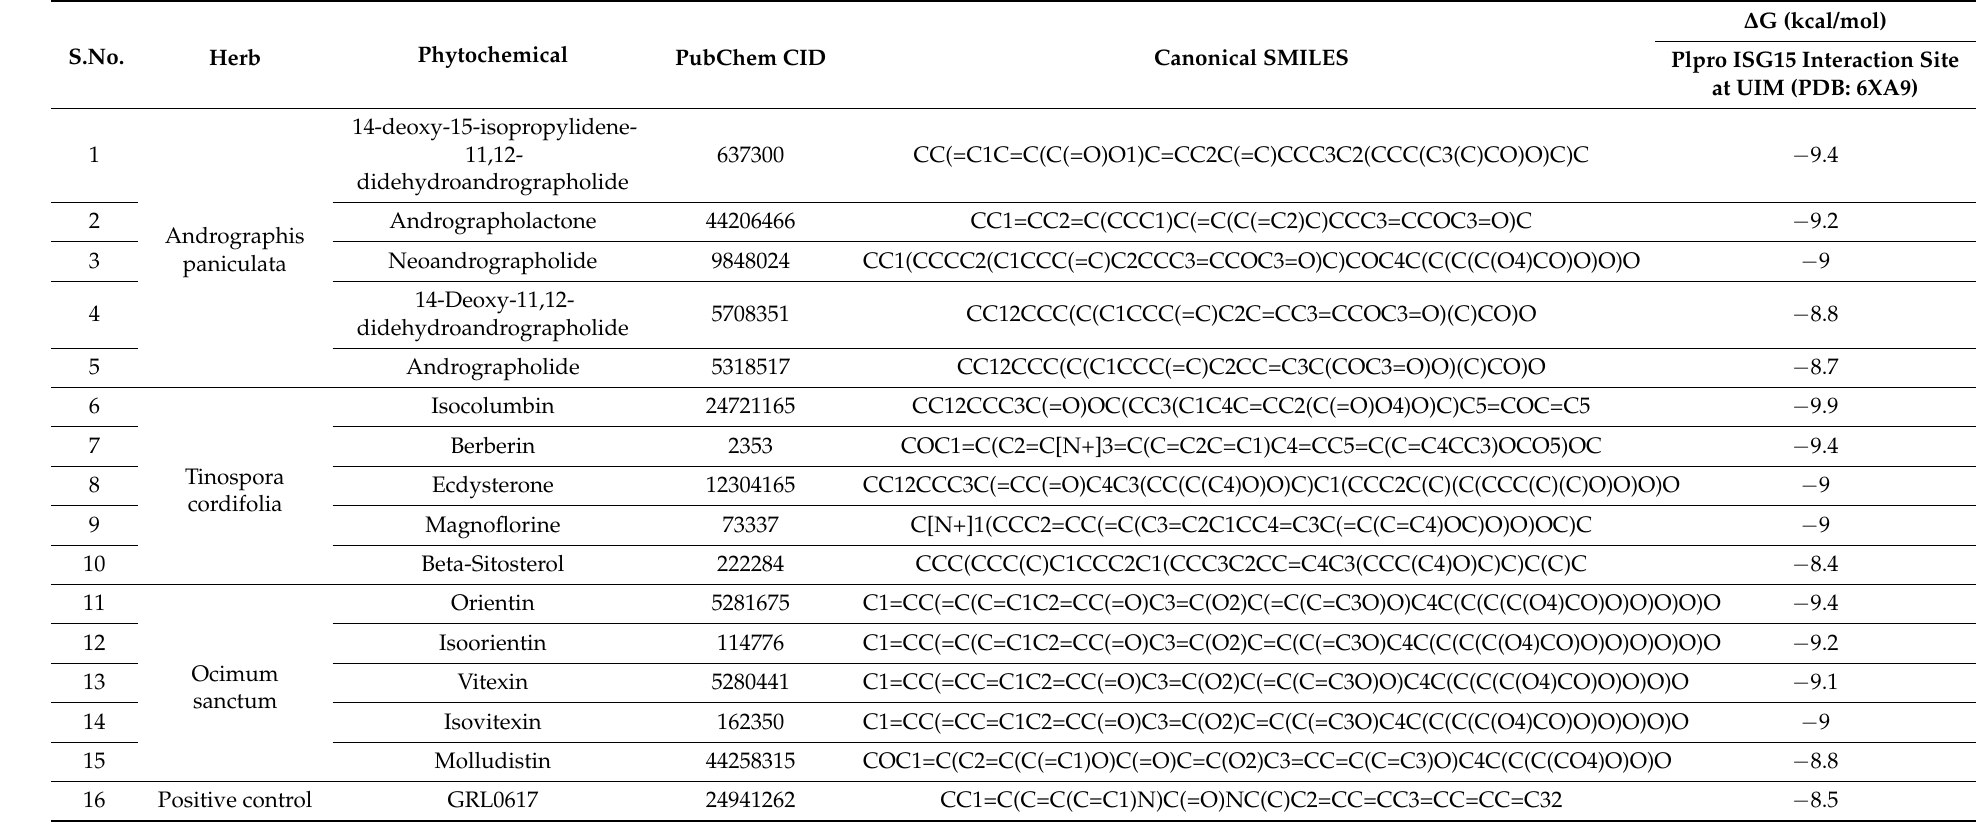
Table 1. Docking scores of various phytochemicals from A. paniculata (AG), T. cordifolia ( GU), O. sanctum (TU) against SARS-CoV-2 (PLpro-ISG15) complex interacting site (PDB